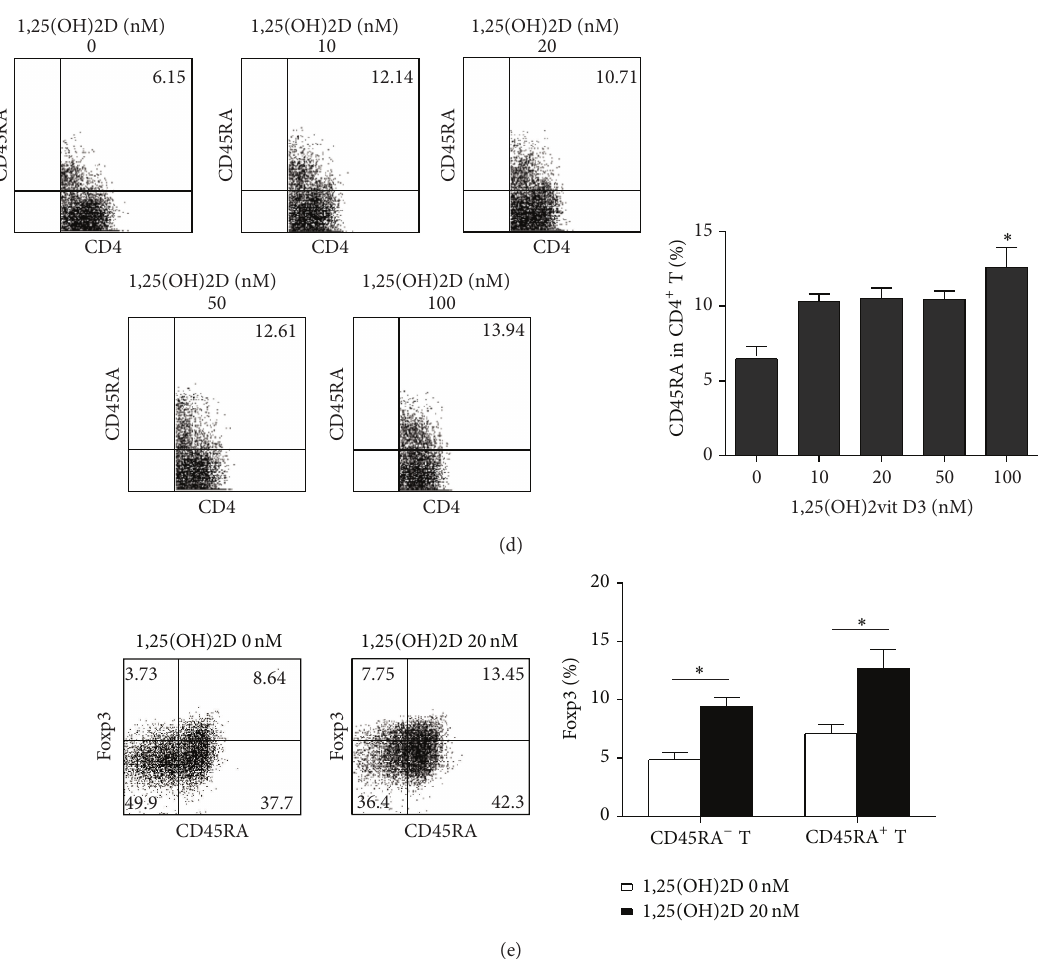
Figure 4: The impact of 1,25(OH)2D on T cell. (a) PBMCs purified from HD were activated by 𝛼 CD3/CD28 with 20 nM 1,25(OH)2D or DMSO. Cells were collected on days 1, 3, and 5 and analyzed apoptosis in CD4 + T cell by FACS. (b) PBMCs were cultured as described with a series of concentrations of 1,25(OH)2D from 10 nM to 100 nM and observed apoptosis in CD4 + T cell on day 3. (c) CD4 + T cell purified from HD were activated by 𝛼 CD3/CD28 monoclonal antibodies with 20 nM 1,25(OH)2D or DMSO. Cells were collected on days 1, 3, and 5 and analyzed CD45RA expression by FACS. (d) CD4 + T cell from CHF was cultured as described with a series of concentrations of 1,25(OH)2D from 10nM to 100 nM and observed CD45RA expression. (e) CD45RA and Foxp3 expressions in CD4 + T cell with or without vitamin d supplement on day 3. Data are representative of three independent